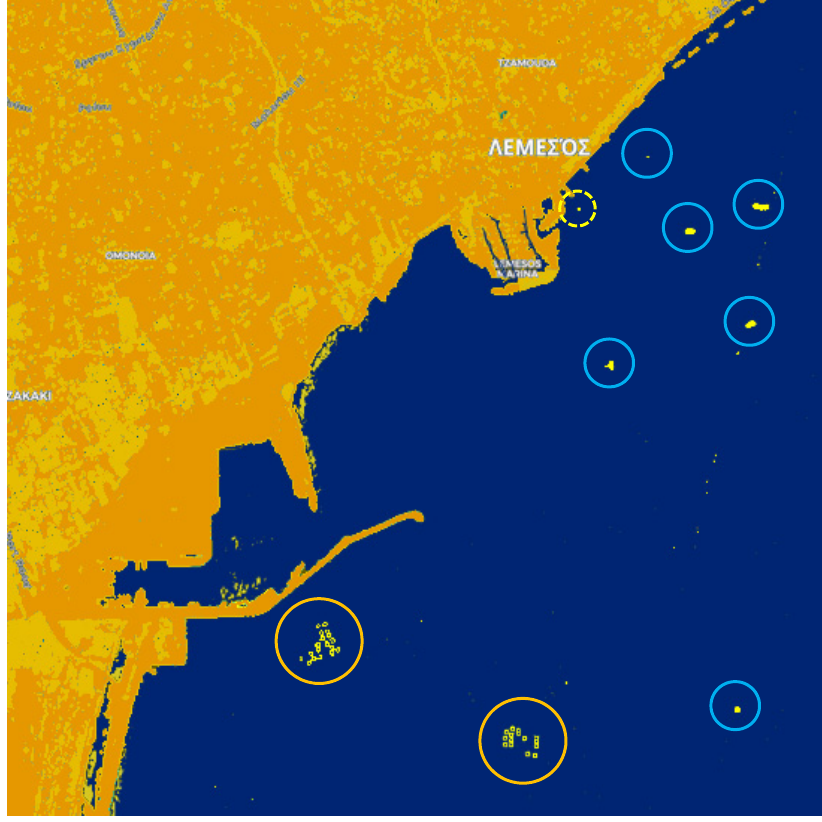
Figure 12. The PI applied to the coast of Limassol. The plastic litter target is in the dashed yellow circle, the floating fish farms are circled in orange and the false positives are circled in blue.